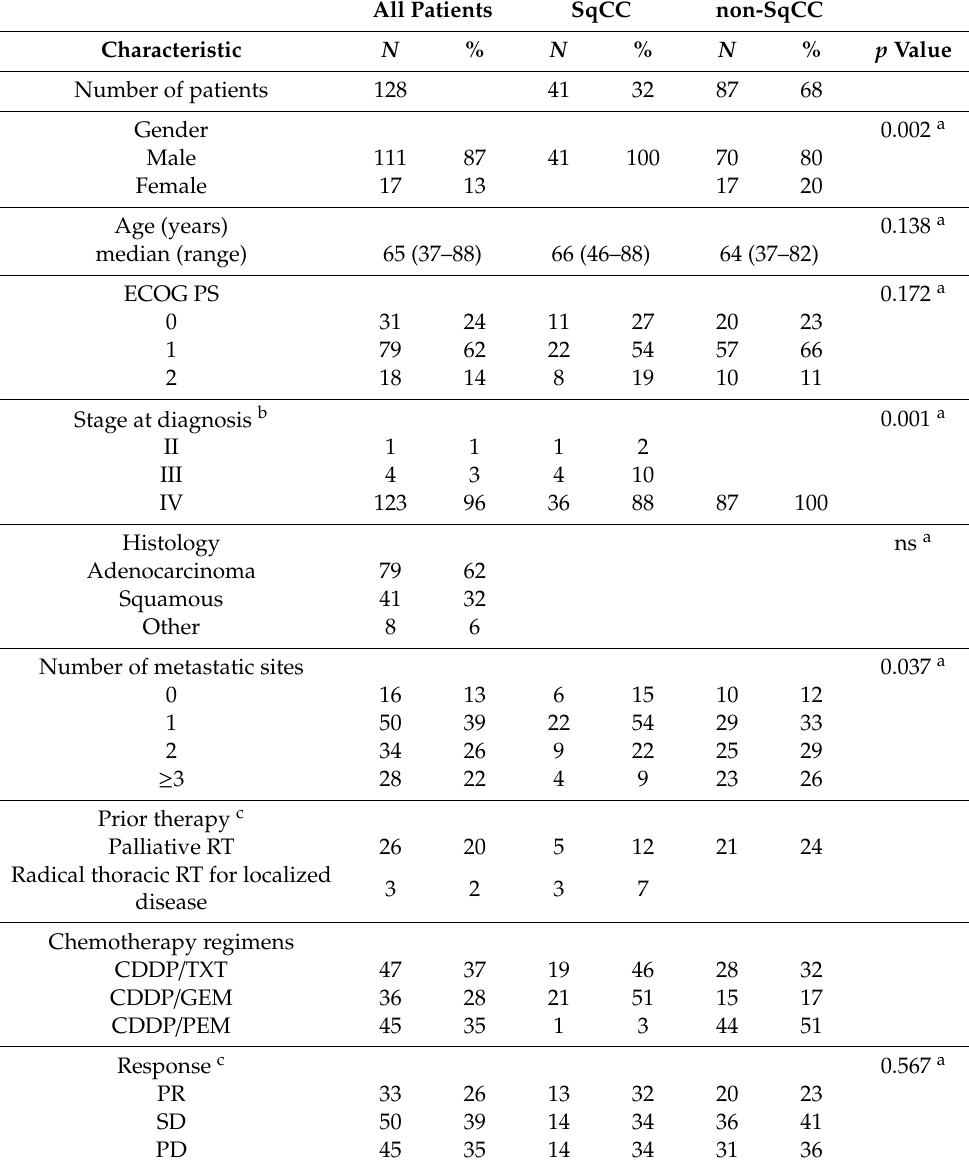
Table 1. Patients’